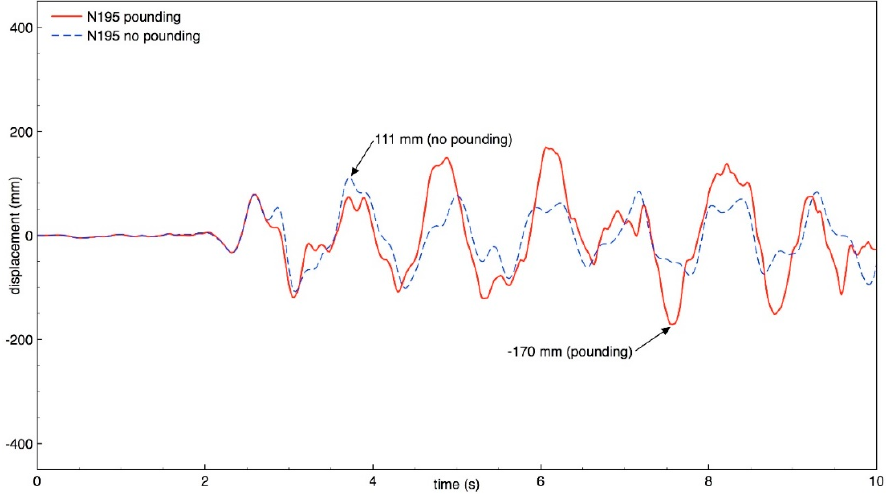
Figure 19. Transverse response of building A (node N364) with and without pounding.